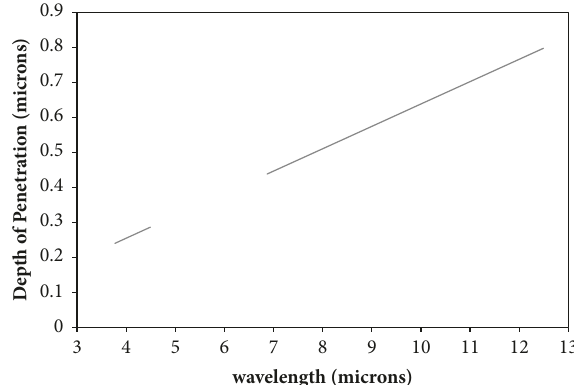
Figure 2: Calculated penetration depth of the QCL wavelength regions, 3.77-12.50 𝜇 m for a Ge